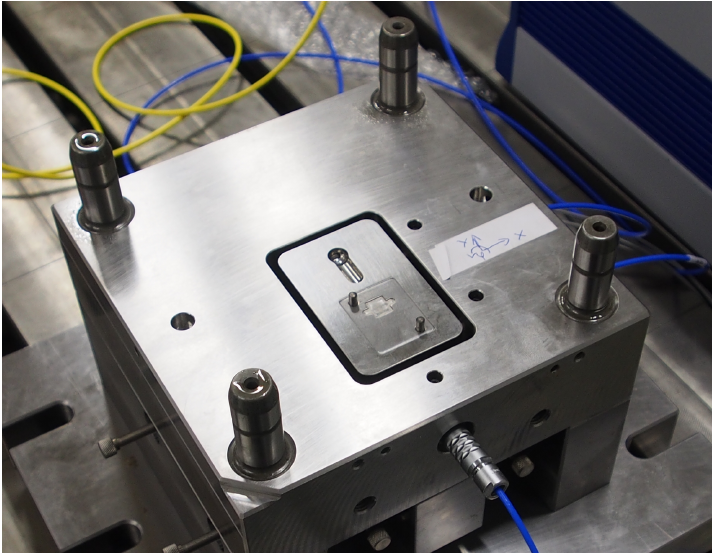
Figure 7. Top view of the mechatronic actuator mounted in the lower part of the mould. The upper part was removed for this image. A part of the injection channel can be seen as well as the dowel pins for mounting the